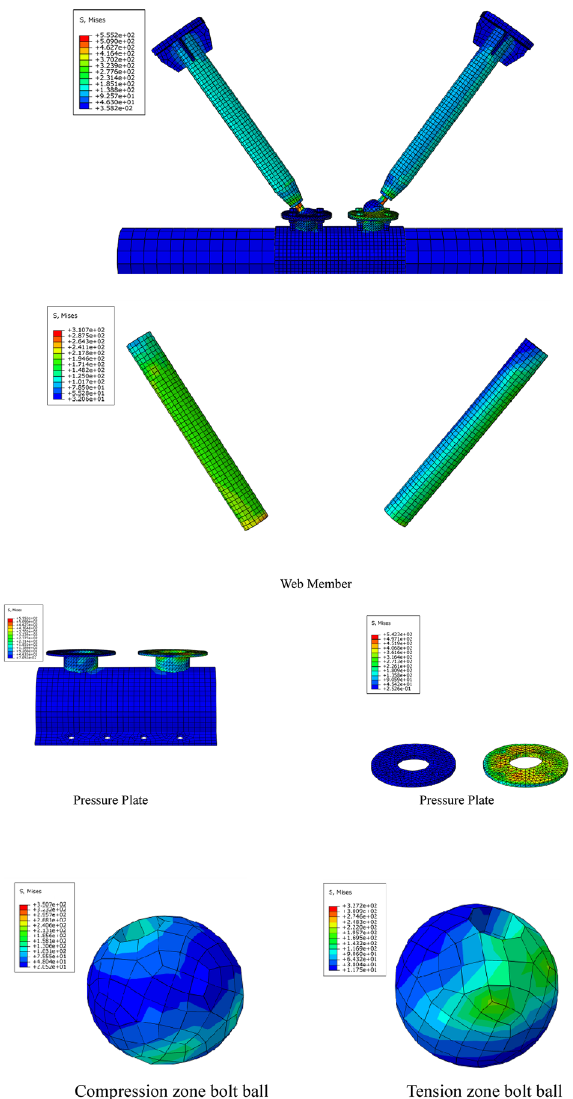
Figure 15. Stress cloud chart (ABAQUS 2020https:// www. 3ds. com/ produ cts- servi ces/ simul